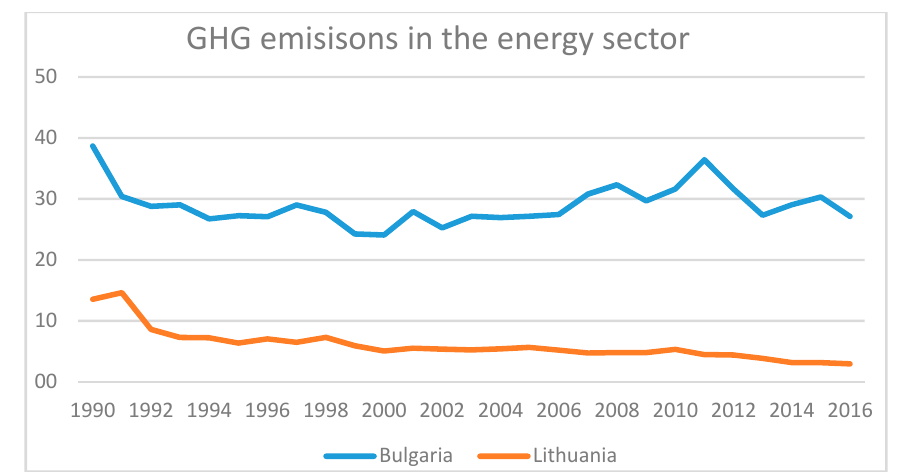
Figure 4. GHG emission from energy industries in Bulgaria and Lithuania, MtCO2 eq. Source: [39,40].